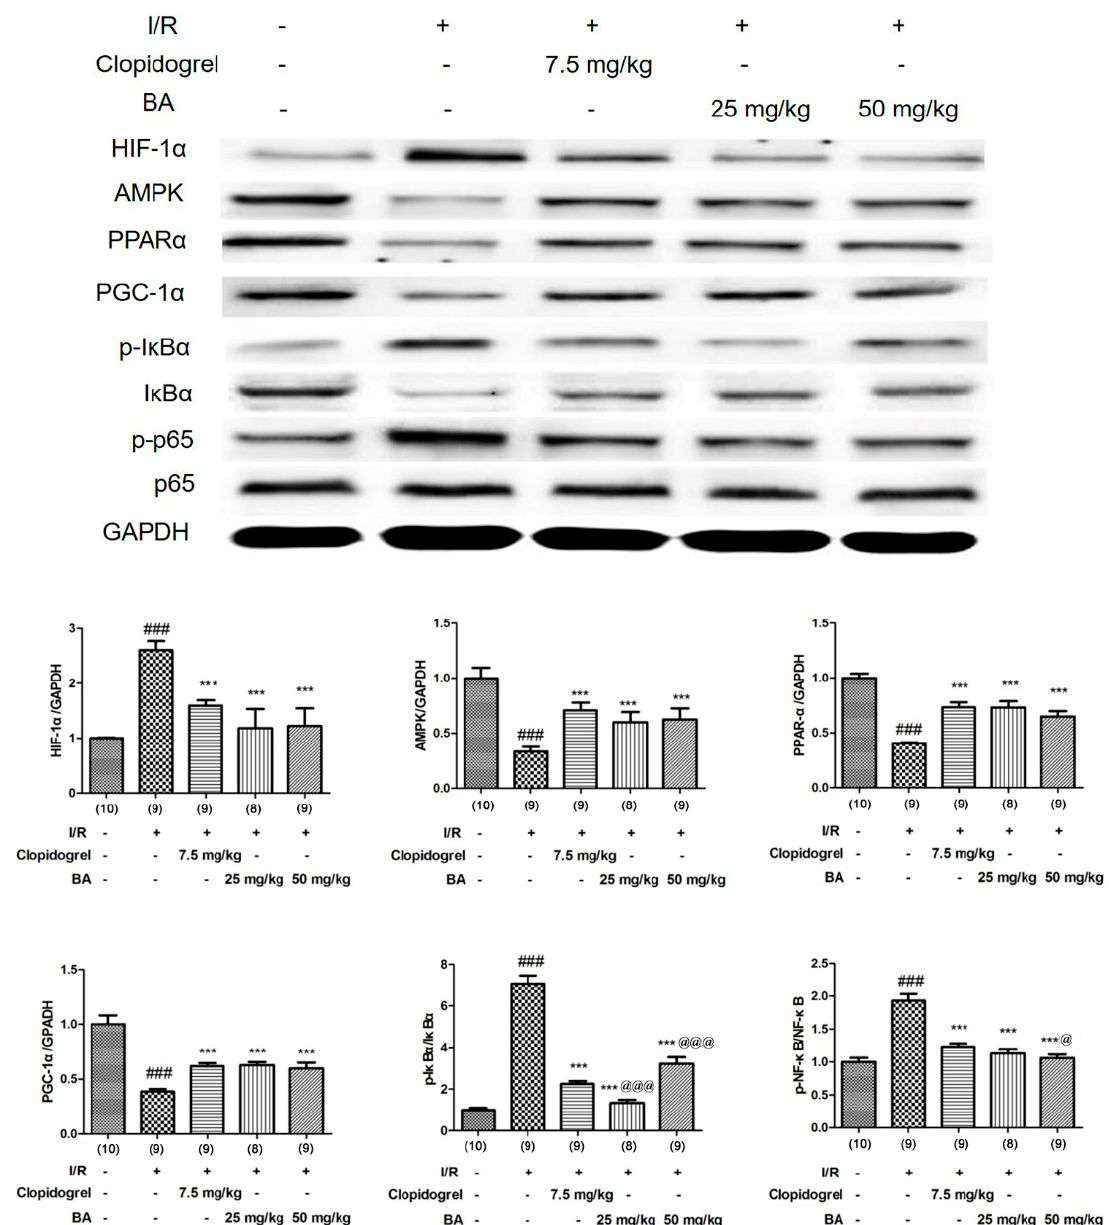
Figure 7. The influence of BA on HIF-1 α , adenosine monophosphate-activated protein kinase (AMPK), perixisome proliferation-activated receptor alpha (PPAR- α ), peroxisome proliferator-activated receptor γ coactivator-1 alpha (PGC-1 α ), I κ B α and NF- κ Bp65 in brain tissues compared with sham rats (### p < 0.001), compared with I / R group (*** p < 0.001) and compared with clopidogrel group (@ p < 0.05 and @@@ p < 0.001). The Arabic number in brackets represent the numbers of animals in each group.